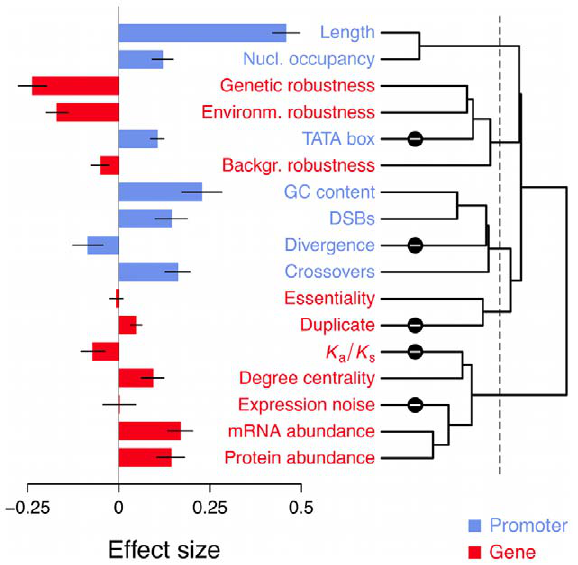
Figure 7. Cis -regulatory element multiplicity is associated with recombination and other genomic features. Relationship be- tween regulatory multiplicity and different genomic features. Bars show the mean and 95% confidence intervals for the effect sizes of the difference between promoters with multiple and single binding sites [39]. The estimates were obtained from a random-effects meta-analytic model fitted using REML. Blue and red bars denote features of the promoter regions and of the genes downstream of these regions, respectively (see Methods for details). Positive values indicate that promoters showing multiple binding site multiplicity tend to show high values of the feature. Promoter length was log-transformed. The dendrogram summarizes the pattern of correlations between different features and was constructed by applying Ward’s hierarchical clustering algorithm to a dissimilarity matrix composed of 1 { D r D , where r is Spearman’s correlation coefficient (see Table S4). Negative signs in the branches leading to a certain feature (e.g., TATA box) indicate that that feature is negatively correlated ( r ) with other features belonging to a cluster defined by the dashed